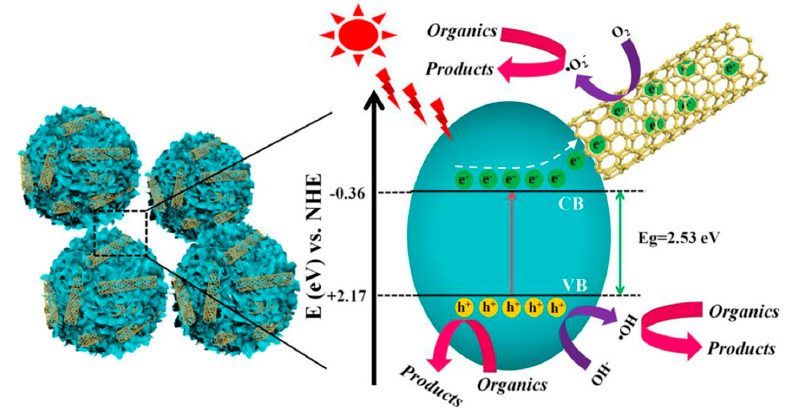
Figure 15. Schematic illustration indicating the reaction mechanism of the photocatalytic procedure of CNT/LaVO 4 composite catalyst. Adapted with permission from Reference [84]. Copyright (2019)